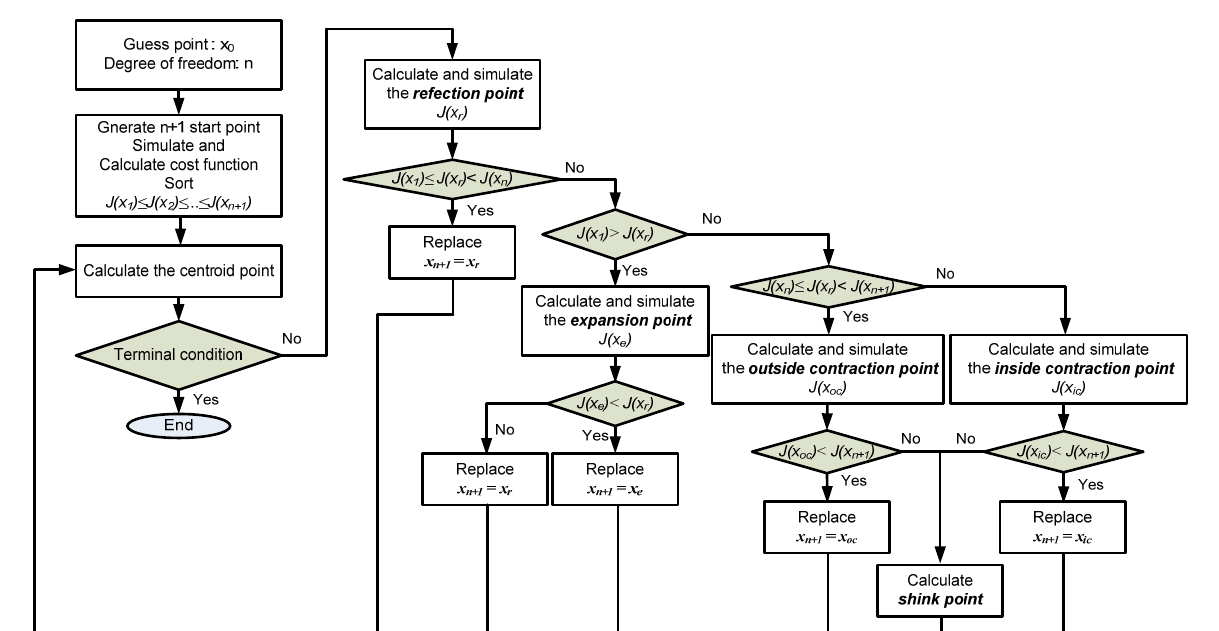
Figure 10. Nelder–Mead simplex method.